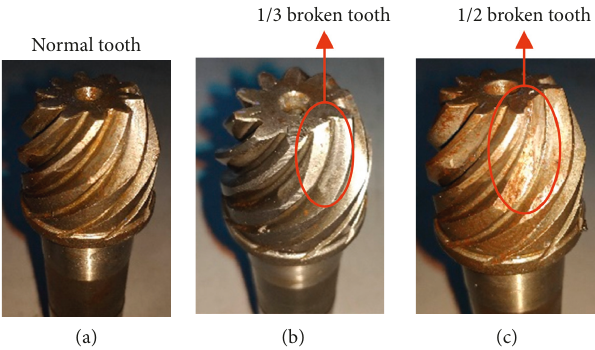
Figure 4: Gears with different degrees of broken